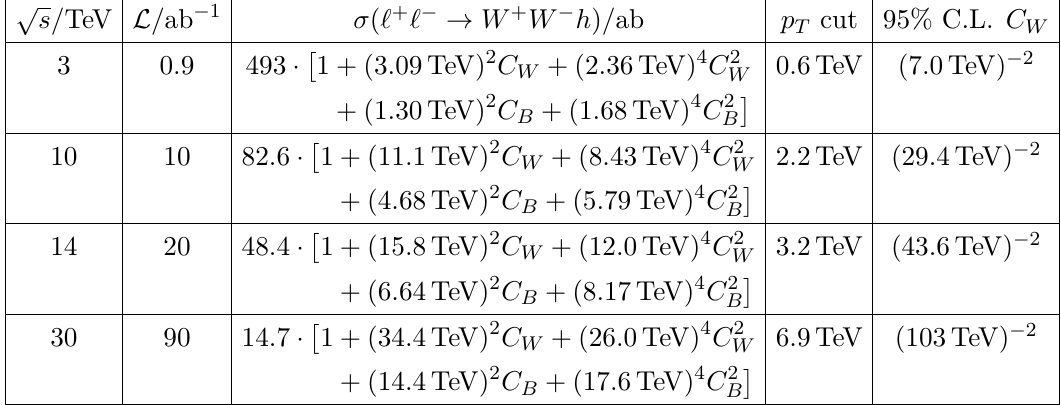
and ‘ + ‘ − → W + W − with a Z → W W or W → W h splitting from one of the heavy